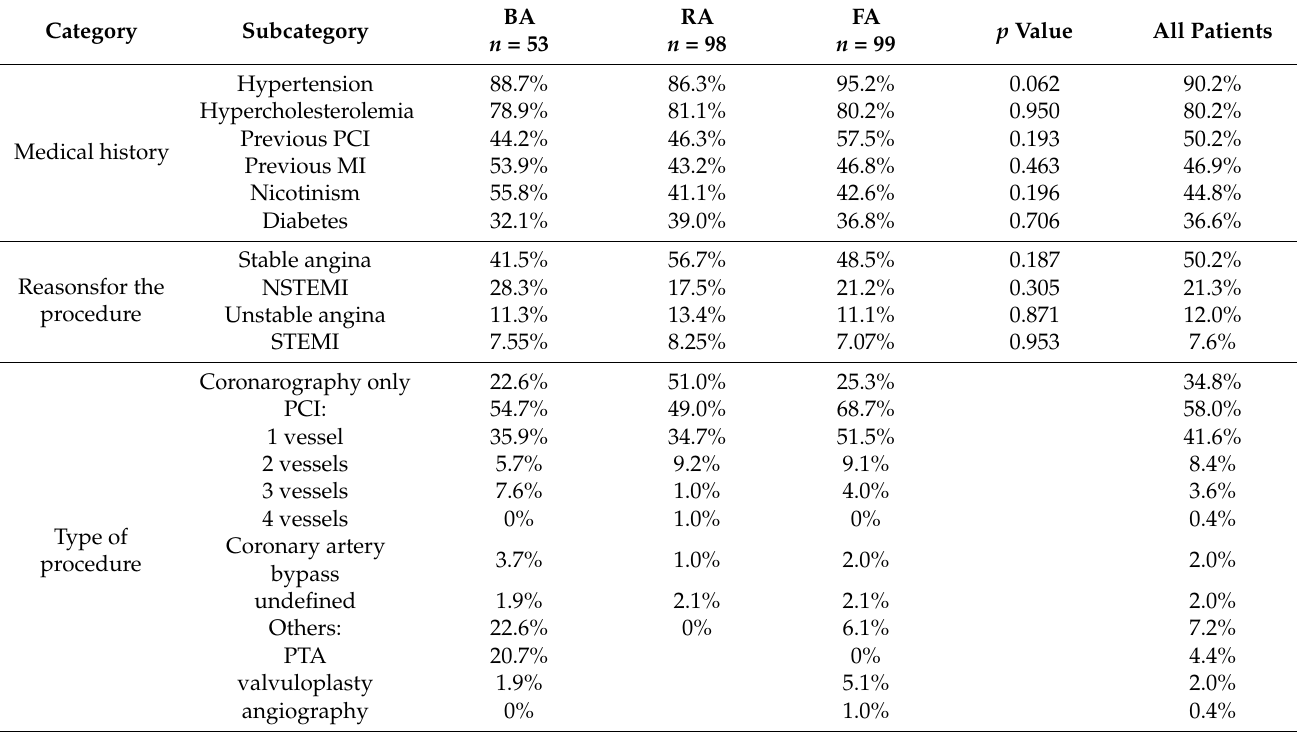
Table 1. Characteristics of patients and